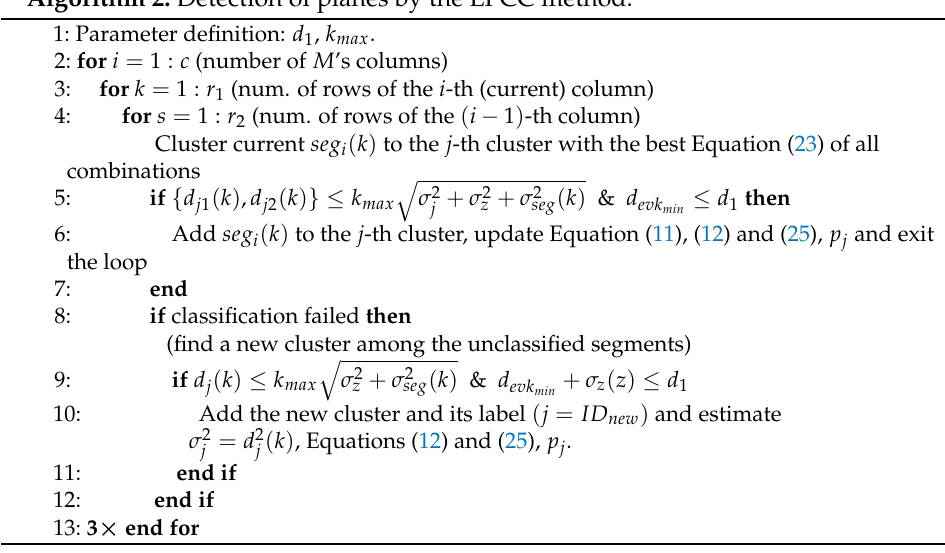
Algorithm 2: Detection of planes by the EPCC method.